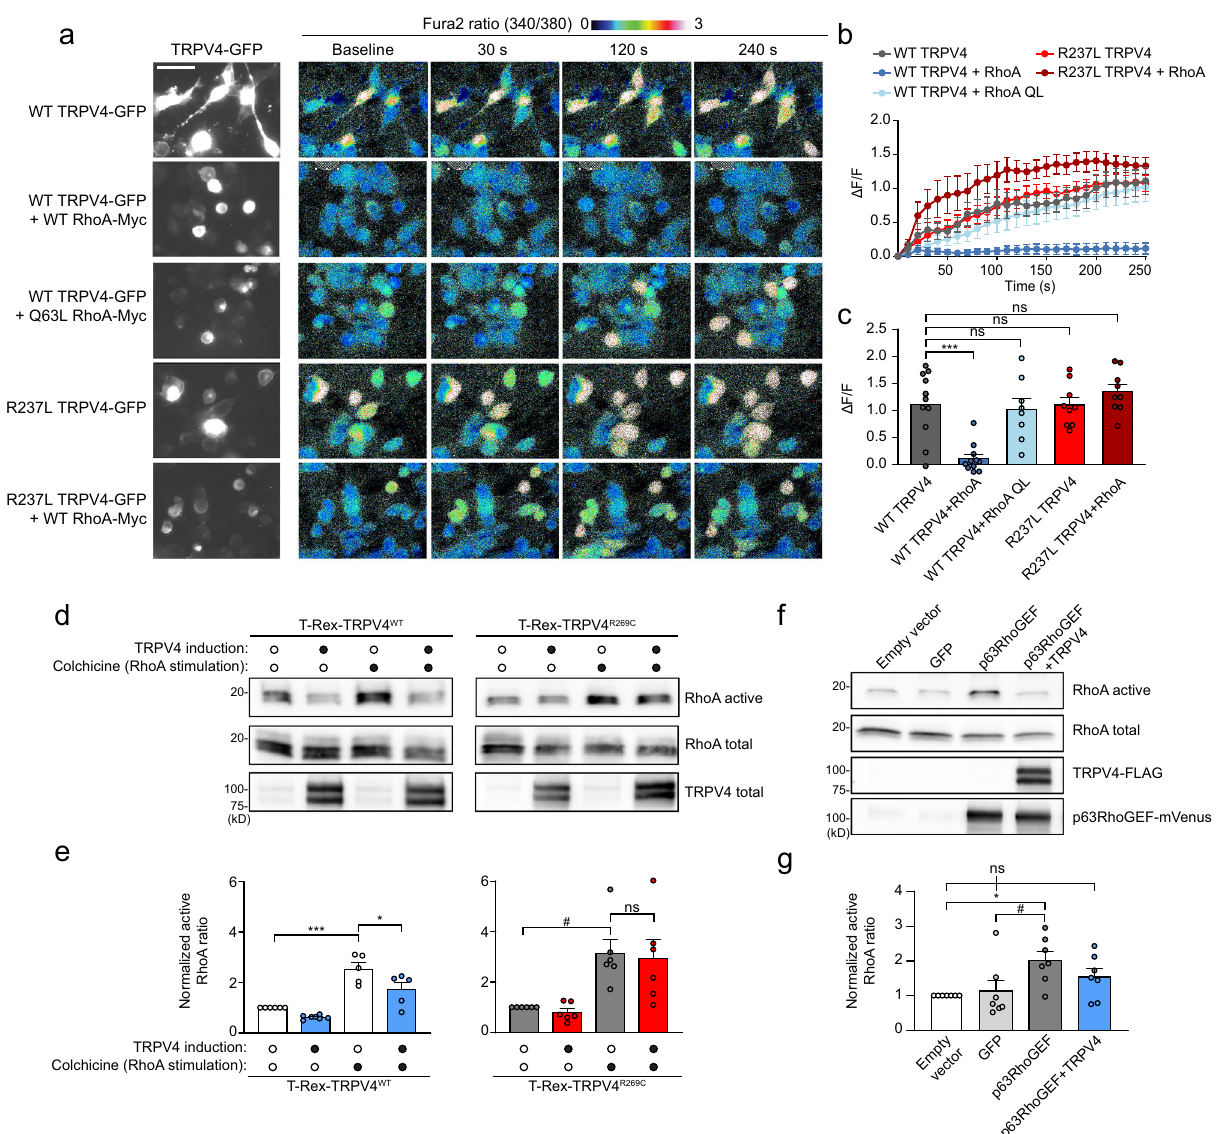
Fig. 4 TRPV4 – RhoA interactions result in reciprocal functional inhibition. a MN-1 cells transfected with WT or R237L TRPV4-GFP alone or in combination with WT RhoA or constitutively active RhoA (Q63L) were loaded with calcium indicator Fura-2 AM and treated with hypotonic saline (30mM NaCl) at time 0. WT RhoA inhibits TRPV4-mediated calcium in fl ux of WT TRPV4 but not R237L TRPV4. RhoA-Q63L does not inhibit WT TRPV4-mediated calcium in fl ux. Scale bar, 50 µ m. b Change in Fura ratio (340/380) divided by baseline Fura ratio ( Δ F/F) in experiments shown in a . n = 9 coverslips per condition. c Change in Fura ratio (340/380) divided by baseline Fura ratio at time = 250 s in experiments shown in a . One-way ANOVA with Tukey post hoc test, n = 9 coverslips per condition, *** p = 0.0002. d T-Rex-TRPV4 cells were uninduced or induced with tetracycline (15ng/ml, 16h), then treated with vehicle or RhoA stimulator colchicine (10 µ g/ml, 45min) followed by analysis of RhoA activation. WT TRPV4 expression reduces basal RhoA activation (lane 2 vs. 1) and colchicine-stimulates RhoA activation (lane 4 vs. 3), whereas neuropathy mutant TRPV4 fails to in fl uence basal or stimulated RhoA activity. e Densitometry of band intensities (active RhoA/total RhoA); representative blots shown in d . Data for T-Rex-TRPV4 WT and T-Rex-TRPV4 R269C conditions were normalized to their respective uninduced and vehicle-treated condition from each cell line. WT TRPV4 but not neuropathy mutant TRPV4 inhibits RhoA activation. One-way ANOVA with Tukey post hoc test, n = 6, * p = 0.046, *** p = 0.0004, # p = 0.030. f HEK293T cells were transfected with empty vector, GFP, p63RhoGEF-mVenus, or p63RhoGEF-mVenus and WT TRPV4-FLAG in the presence of HC067 (0.5 µ M), and RhoA activity was analyzed after 24h. Expression of p63RhoGEF leads to increased RhoA activation that is inhibited by WT TRPV4. g Densitometry of active RhoA band intensity, normalized to empty vector transfection; representative blot shown in f . One-way ANOVA with Tukey post hoc test, n = 7, * p = 0.028, # p = 0.020. Data are presented as means± SEM. Further details regarding the number of times experiments were repeated are presented in “ Methods ” under “ Statistics and reproducibility ” calcium. We found that induction of WT TRPV4 expression in basal RhoA activation (Fig. 4d, e, compare lanes 1 and 2 of T- the presence of HC067 had an inhibitory effect on basal levels of Rex-TRPV4 R269C blot), consistent with a requirement for binding of TRPV4 and RhoA for inhibition of RhoA activation. active RhoA (Fig. 4d, e, compare lanes 1 and 2 of T-Rex- Having observed basal inhibition of RhoA by TRPV4, we next TRPV4 WT blot), suggesting that TRPV4 attenuates activation of RhoA. In contrast, neuropathy mutant TRPV4 did not inhibit investigated whether TRPV4 in fl uences activation of RhoA in